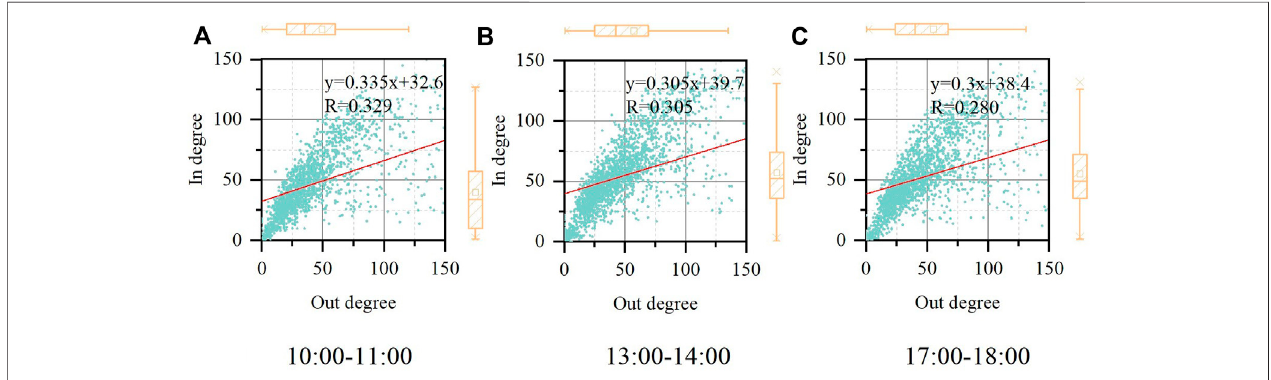
FIGURE 9 | Degree distribution of unweighted social contact networks in different time intervals: (A) 10:00 – 11:00; (B) 13:00 – 14:00; (C) 17:00 – 18:00.